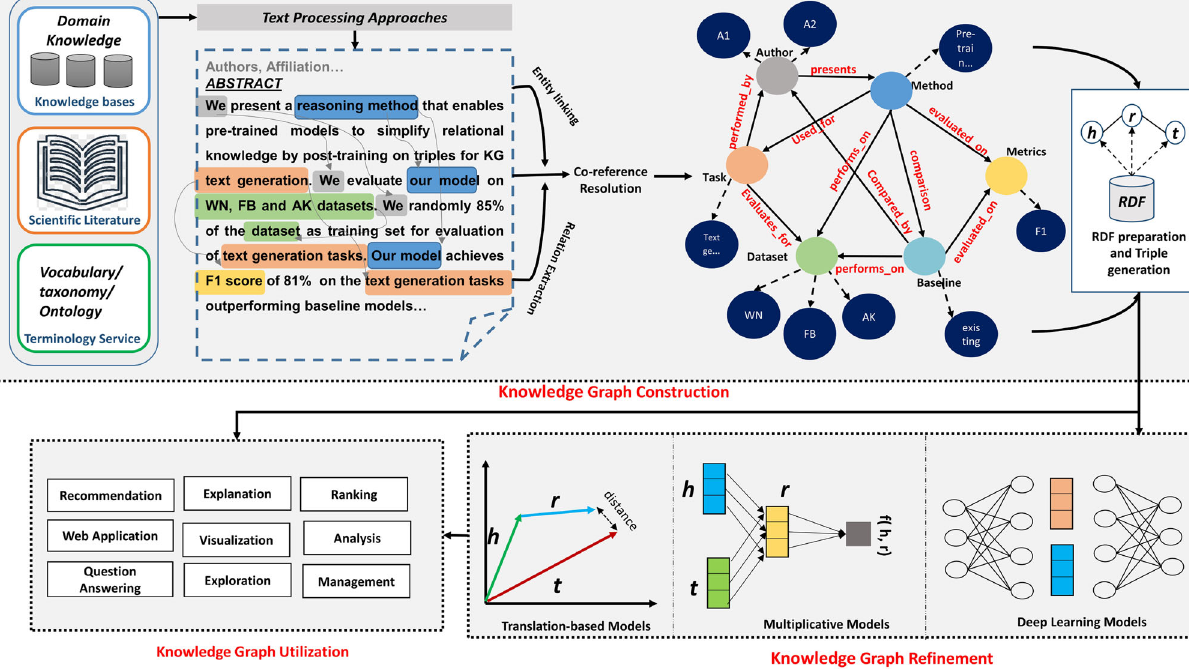
Fig. 3 Conceptual view of the process of data mining in scholarly knowledge